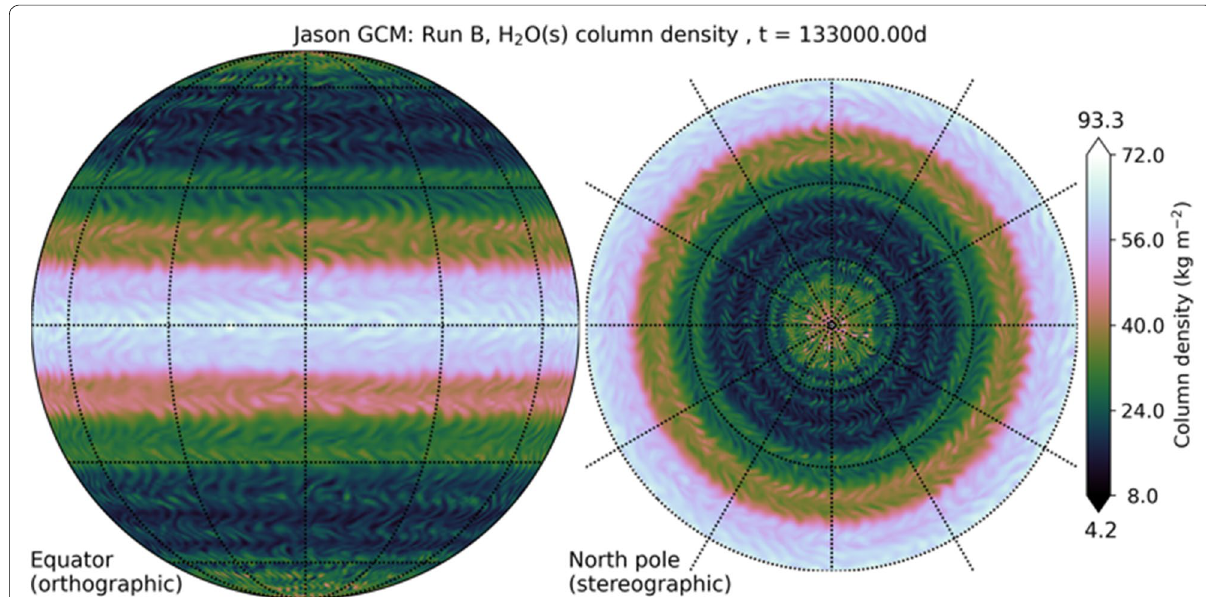
Fig. 5 Visualisation of a snapshot of the field of water cloud ice column density from a simulation of the weather layer circulation of Jupiter at a horizontal resolution of 0.7° 0.7° in latitude longitude using the Jason model (Young et al. 2019b). This simulation does not include moist × × convection